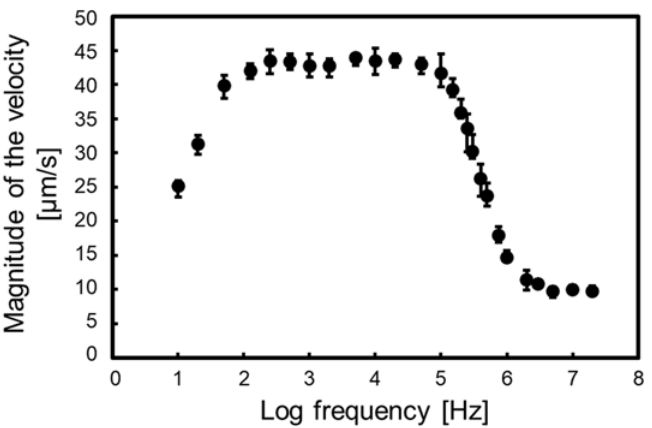
Figure 9. Particle velocity against the applied frequency. The velocity was measured from 10 Hz to 20 MHz. The error bar of the plot shows the maximum and minimum velocity in the measurement. The velocity was calculated from the travel time, using x = 135 to 115 µm, as shown in Figures 4 and